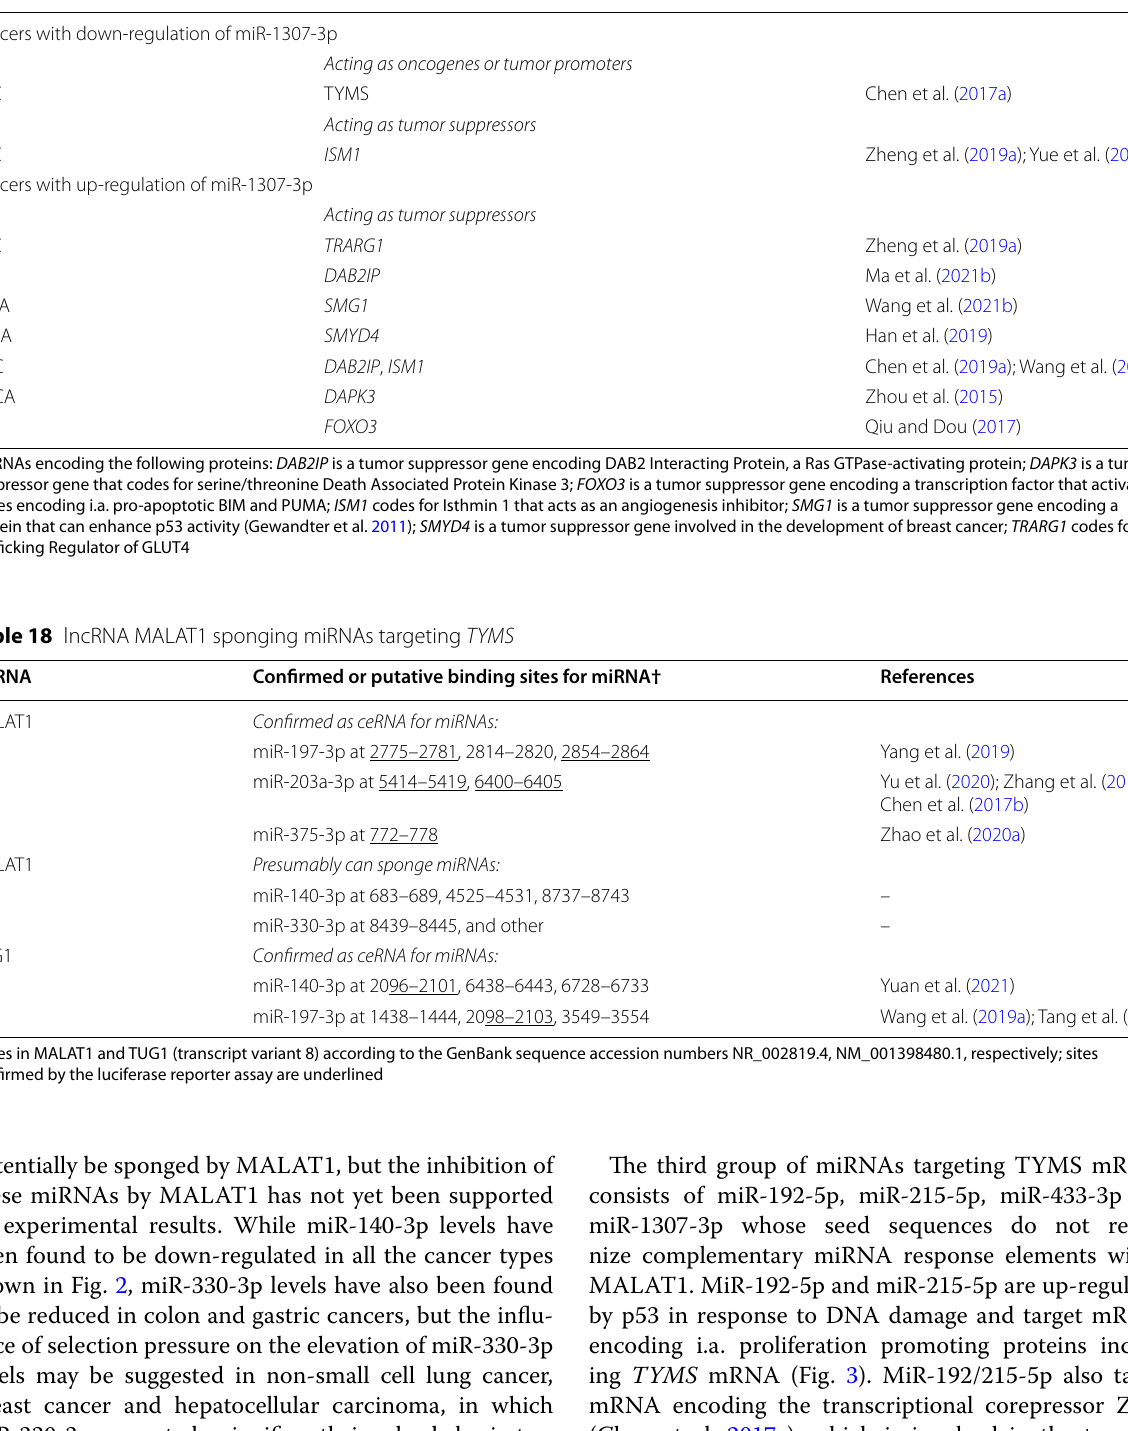
Table 17 Major genes targeted by miR-1307-3p in various types of cancer